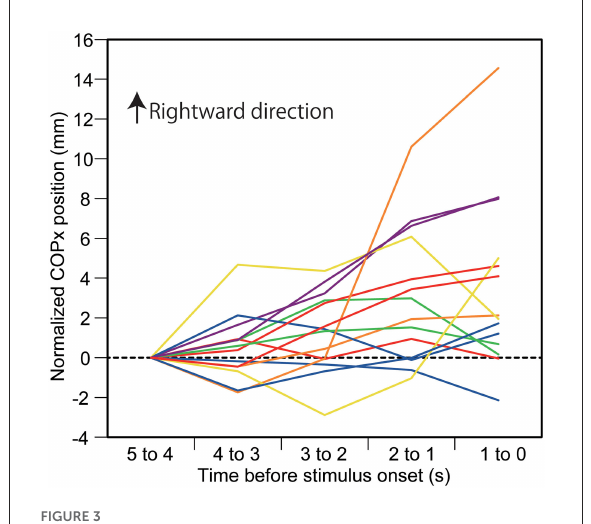
FIGURE3 Individual data on the COPx position in auditory stimulus trial block. Each line indicates the COPx position in each participant. The data are normalized by subtracting the average value at 1–0s before the onset of the visual cue (5–4s before the stimulus) from the values averaged at every 1s in the time window between 4 and 0s before the